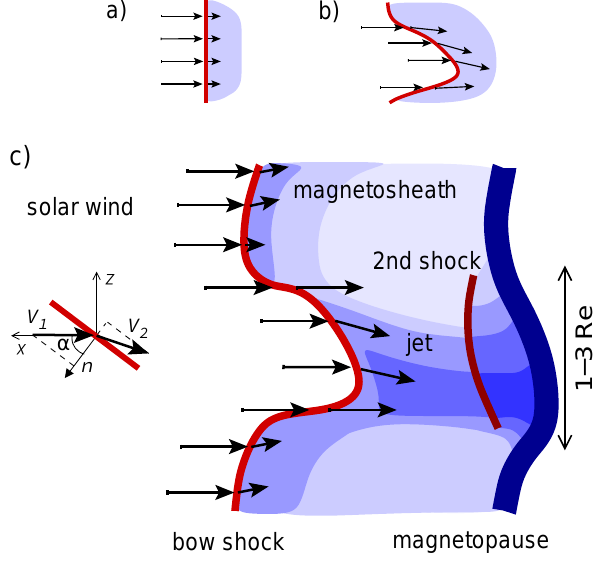
Fig. 1. Top: schematic picture of the velocity field across a high Mach number shock that is either planar (a) or rippled (b) . The red line depicts the shock, and the blue area is the downstream side. Bottom: illustration of the effect of a bow shock ripple, adapted from Hietala et al. (2009). The variation of the plasma number density in the downstream region is illustrated by the shading: dark blue indicates density enhancement, light blue indicates density depletion. The jet perturbs the magnetopause which is depicted by the thick blue line. In the particular case where the jet is supermagnetosonic in the frame of the magnetopause, an additional, weak shock forms. The inset details the flow deflection when V 1 is not parallel to n . Note that the picture is not to scale in the horizontal direction.